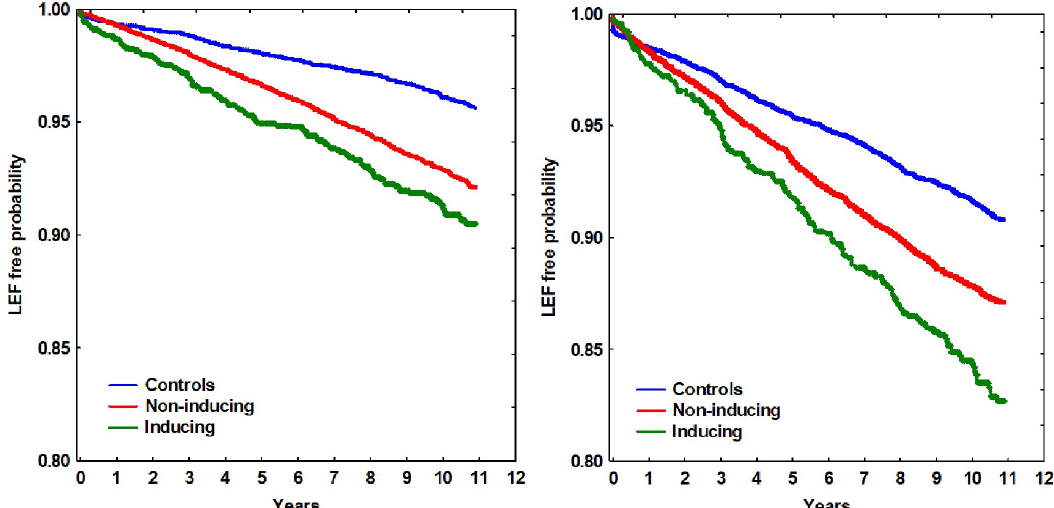
Fig 2. Low energy fracture-free probability over time in relation to type of antiepileptic drug, compared to controls for men (left) and women (right), respectively.